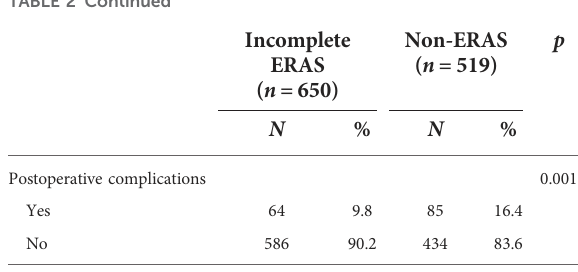
TABLE 2 Characteristics of all patients before